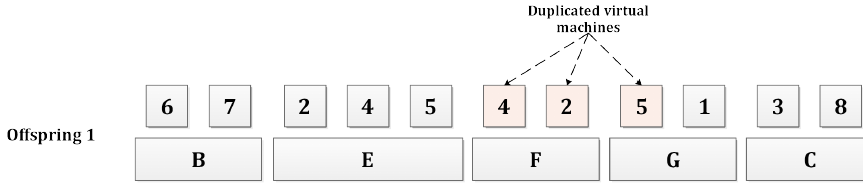
Figure 6. Insert the group E on the selected intersection on Y.